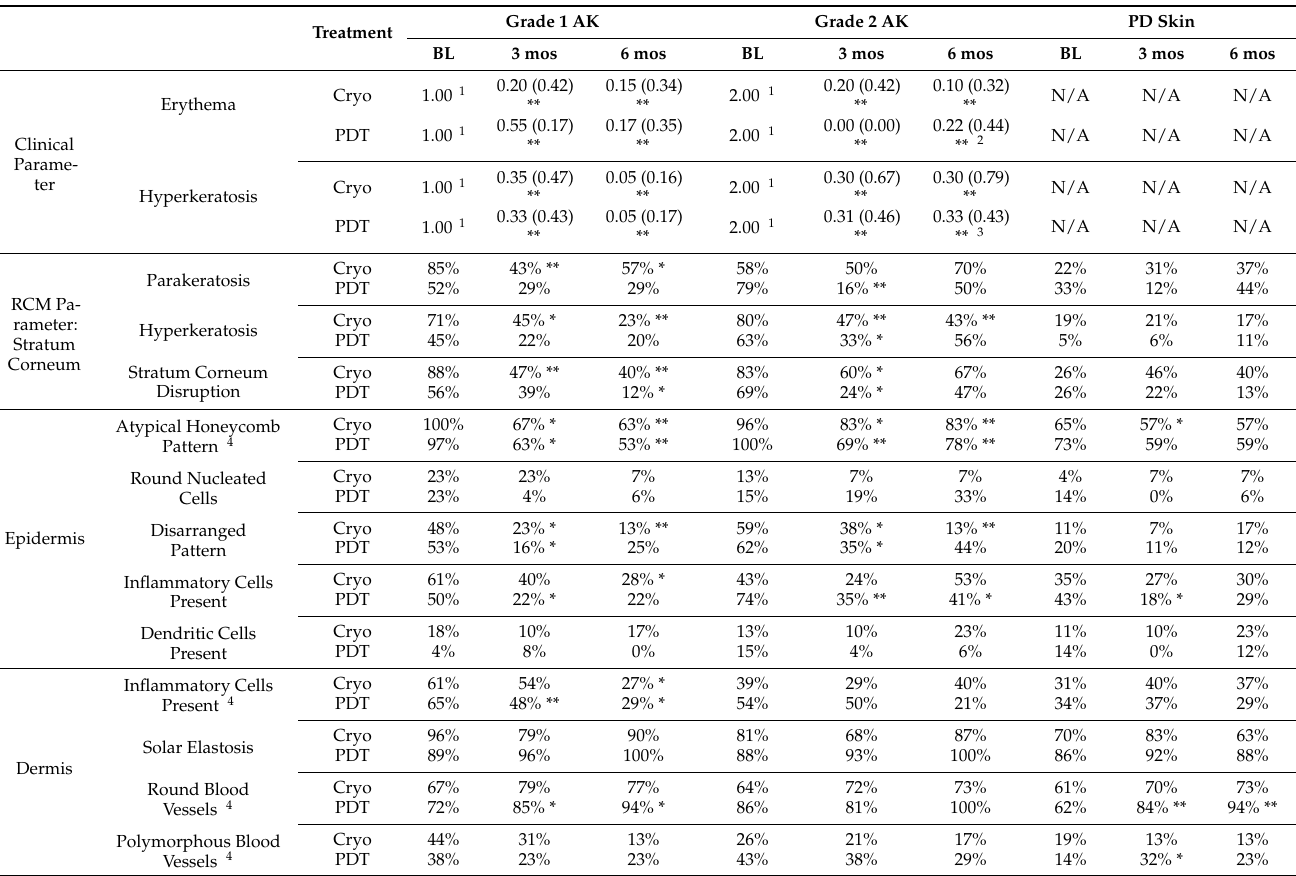
Table 4. Mean (standard deviation) clinical scores over time and RCM parameter prevalence over time in cryotherapy and PDT